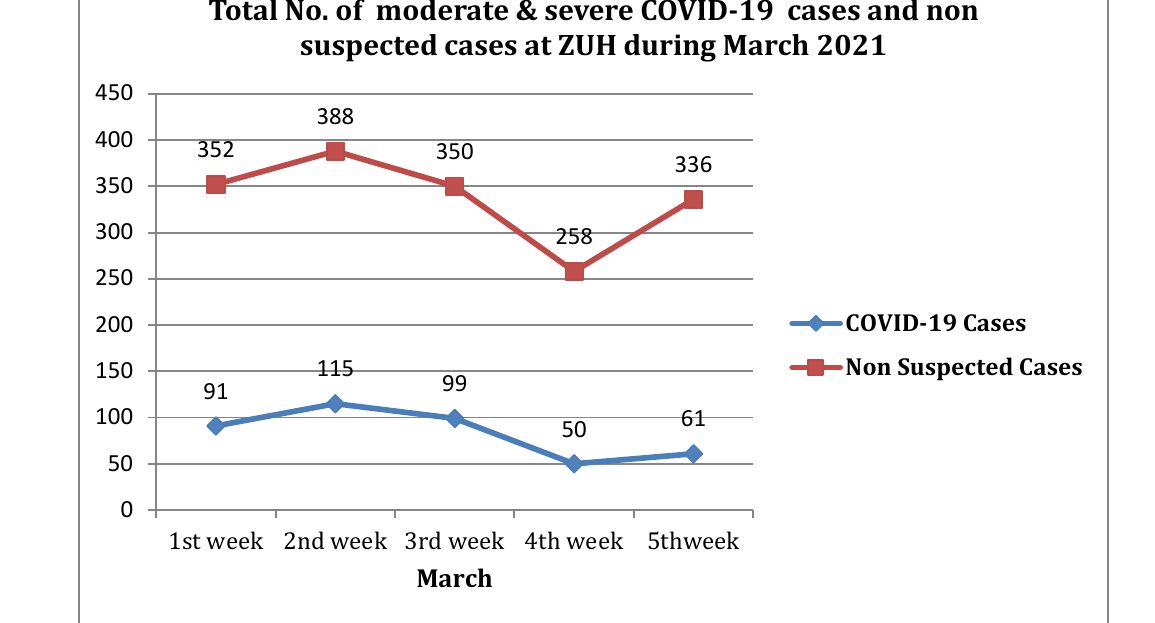
Figure 3 . Total No. of moderate and severe COVID-19 cases in comparison to unsuspected cases at ZUH during March 2021.